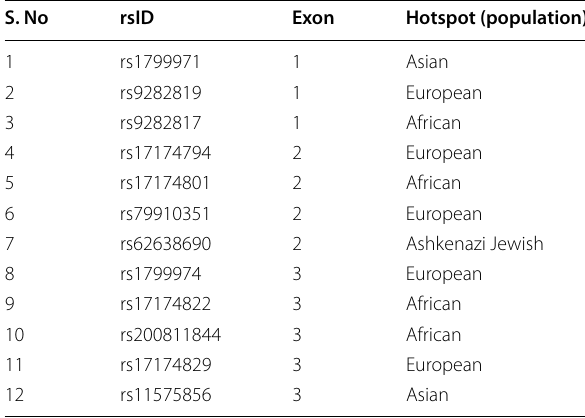
This table explains the different exons and hotspot regions in population-based variants